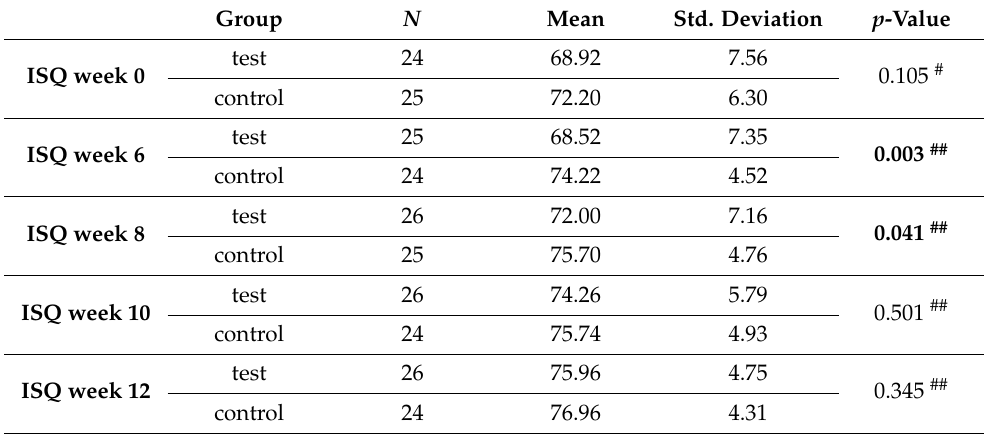
Table 3. The results of implant stability quotient (ISQ) measurement at different time points after implant placement. Statistical significance ( p < 0.05) is highlighted in bold. Abbreviations: one-way ANOVA (#), independent-samples Mann–Whitney U test